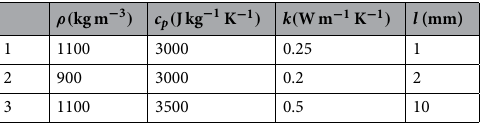
Table 1. Thermal parameters of the considered medium.